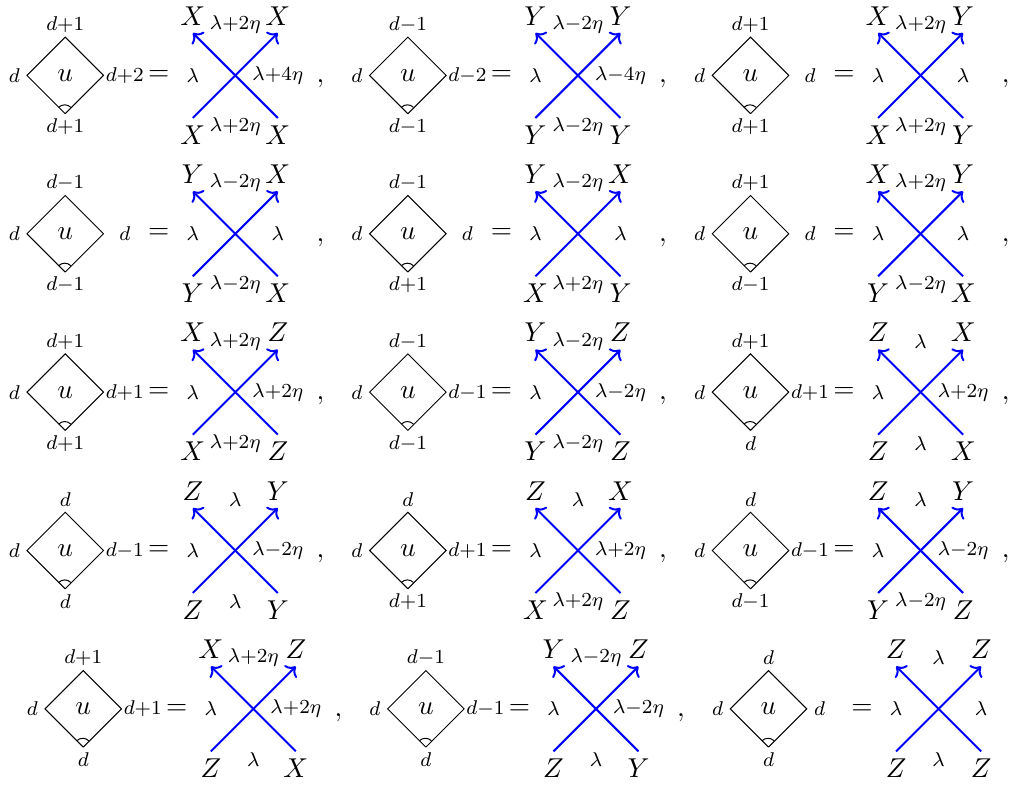
-type model with those 2 quiver theory we are studying, the functional 2